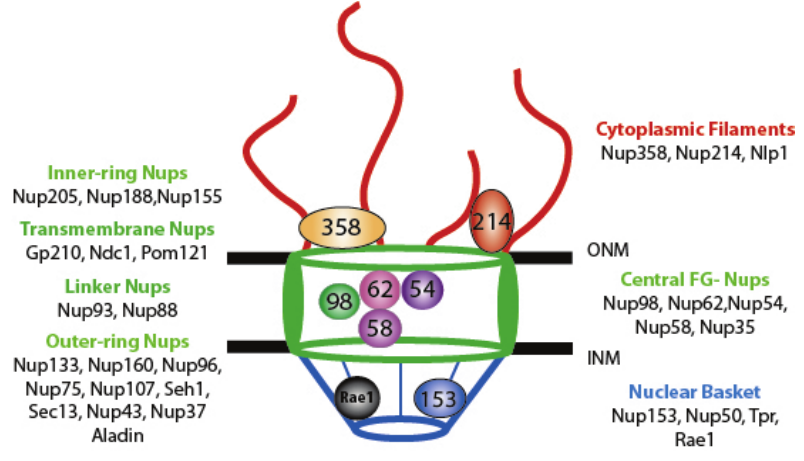
Figure 1. The nuclear pore complex (NPC). Schematic representation of a cross-section view of a NPC as it spans the inner (INM) and outer (ONM) nuclear membranes. Vertebrate Nups are listed based on their localization within the NPC. The central core (green) is composed of the inner-ring Nups, transmembrane Nups, linker Nups, outer-ring Nups and the phenylalanine-glycine (FG)-Nups. The location of select nucleoporins within the NPC is